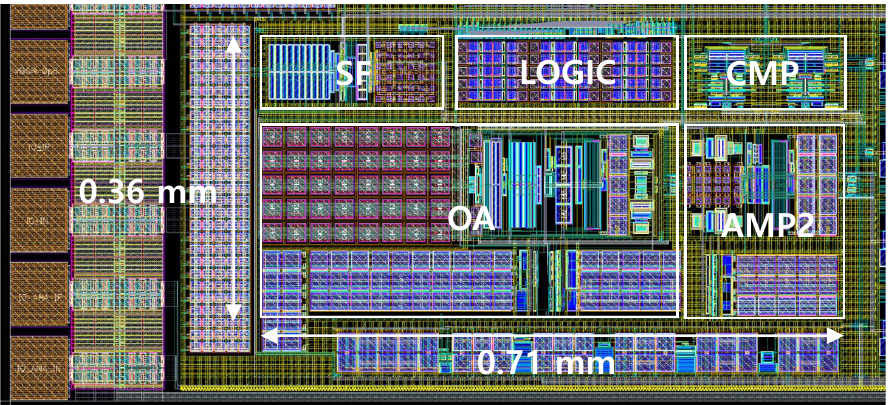
Figure 14. The layout of the proposed circuit and the regions of the main blocks of SF and SAM. Figure 15 shows the frequency response and noise characteristics of analog blocks. In Figure 15a, the dotted line and the solid line correspond to the frequency response characteristics when SF is in the low power mode and the normal power mode, respectively. In the low-power mode, a current of 100 nA flows through the input MOS of the source follower and has a bandwidth of about 56 kHz. In the normal power mode, a current of 7.6 µ A flows through the input MOS of the source follower and has a bandwidth of about 3.5